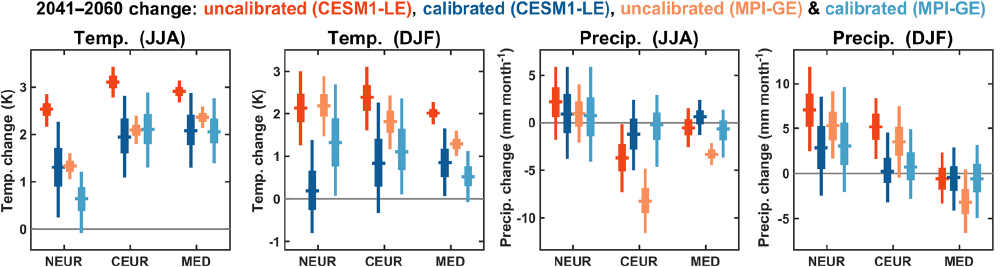
Figure 8. The 2041–2060 mean calculated relative to the 1995–2014 climatology for both CESM1-LE and MPI-GE, calibrated using the HGR-decomp method to the observations over the period 1920–2016. The vertical lines show the 90% range of the ensemble, thick boxes show the interquartile range and horizontal lines show the ensemble